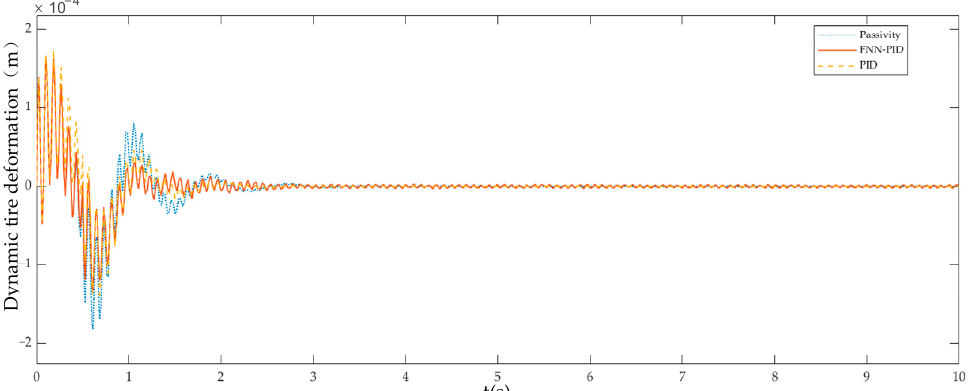
Figure 6. Step response diagram of Dynamic Deflection of Suspension.